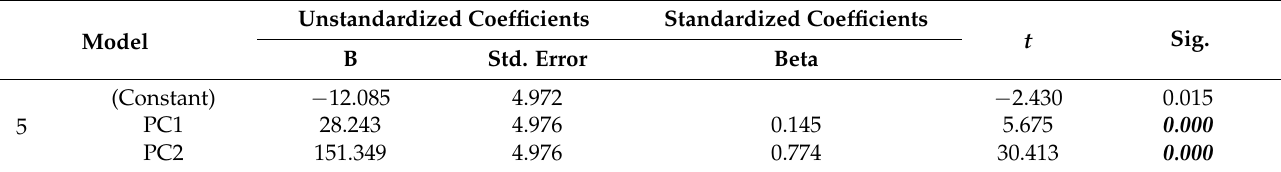
Figure 11. Component plot in rotated space. The second regression model, Model 5, has a good value for R 2 (0.621), and the ANOVA test indicated that Model 5 is statistically significant ( p -value = 0.000). The values for standardized beta coefficients are presented in Table 6. Table 6. Coefficients for Model 2.